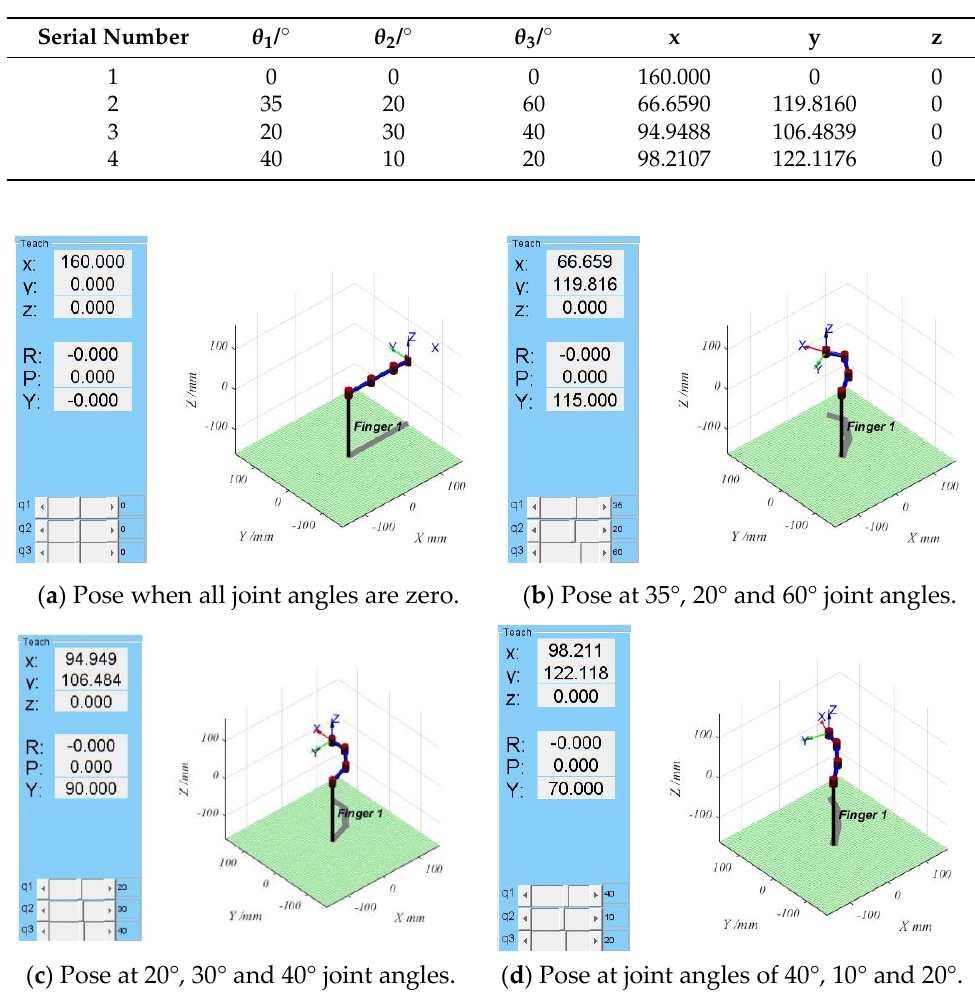
Figure 13. Simulation results of the single- fi nger model.